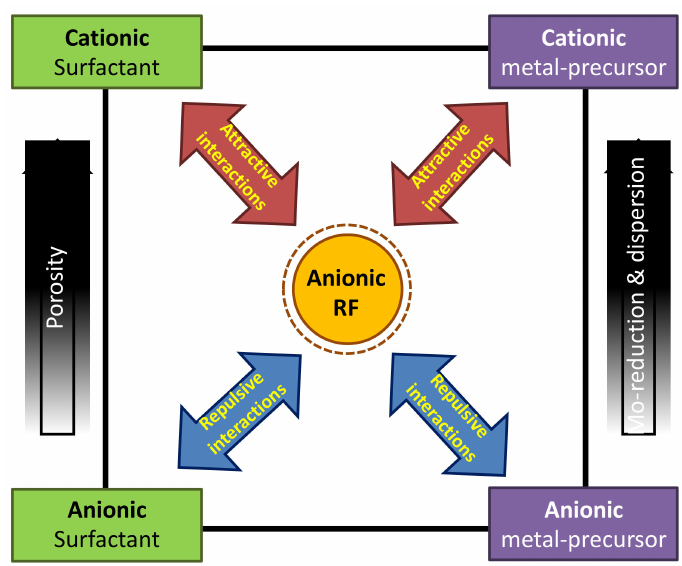
Figure 8. Scheme of the synthesis of Mo-doped carbon gels with special emphasis on the electrostatic interactions between surfactants, metal precursors and organic RF-matrix.